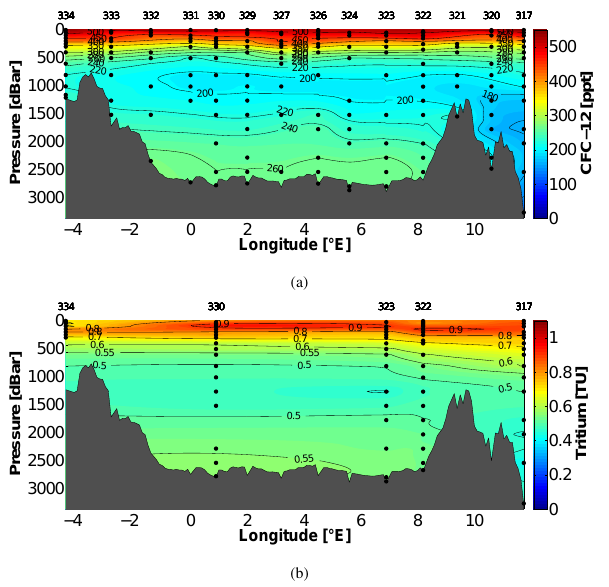
Figure 9. (a) CFC-12 concentration in ppt and (b) Tritium concen- Fig. 9: ( a ) CFC-12 concentration in ppt and ( b ) Tritium concentration in TU of the Western Basin and the Tyrrhenian Sea, blue tration in TU of the western basin and the Tyrrhenian Sea, blue line line in Fig. 6. in Fig. 6.